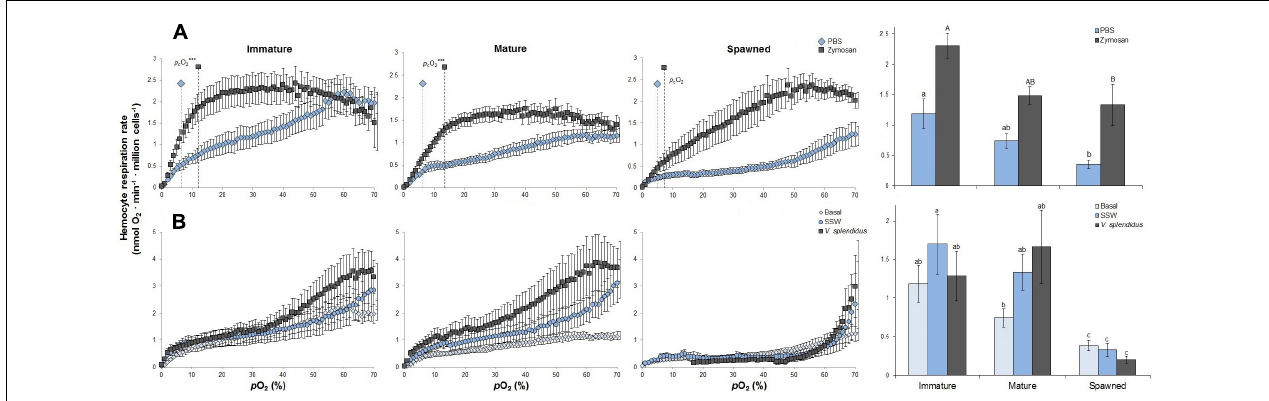
FIGURE 1 | Effects of (A) in vitro challenge with zymosan and (B) in vivo challenge with Vibrio splendidus on hemocyte respiration rates and critical O 2 ( p c O 2 ) (only for in vitro ) from immature, mature, and spawned Argopecten purpuratus ( n = 4–8 per condition and treatment). For bar graphs, values associated with the same letter belong to the same subset based on a posteriori multiple comparison test Student-Newman-Keuls. ∗∗∗ P < 0.001.